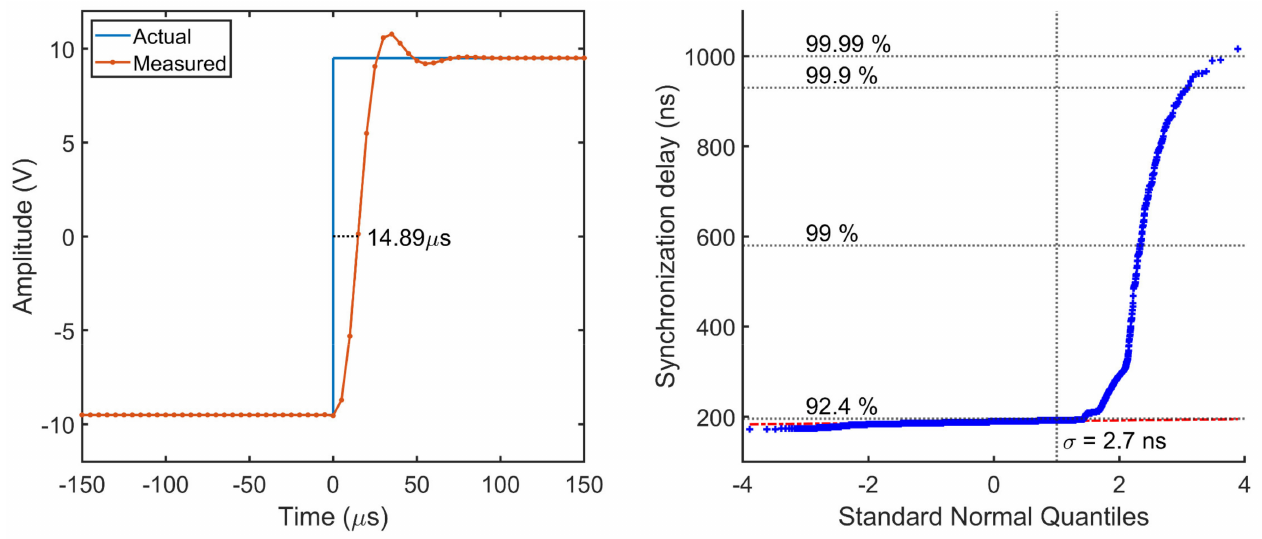
Figure 12. Step response ( left ) and synchronization delay quantile-quantile plot ( right ). The delay introduced by the SMU in the synchronization with the time reference signal was evaluated from N = 10 4 measurements. Results in Figure 12 show an average delay of 188.7 ± 2.7 ns in the 92.4% of the cases, which is between 2 and 3 orders of magnitude smaller than best performance achievable on a real-time OS with kernel preemption. In a small percentage of cases, between 92.4% and 99%, the delay can reach up to 580 ns, and 930 ns in 0.9% of the cases. Exceptionally, only in one case the synchronization delay has reached 1 µ